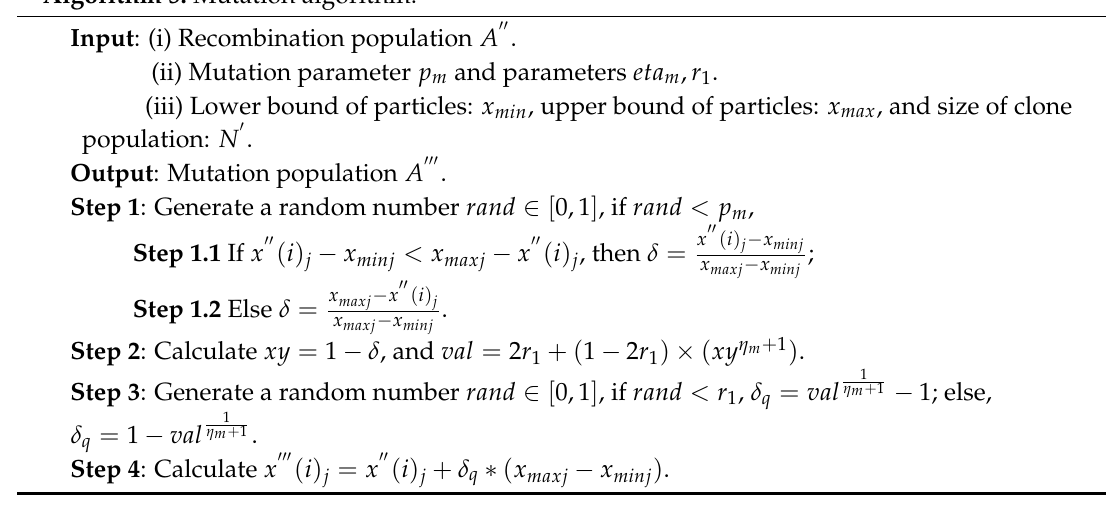
Algorithm 5: Mutation algorithm.